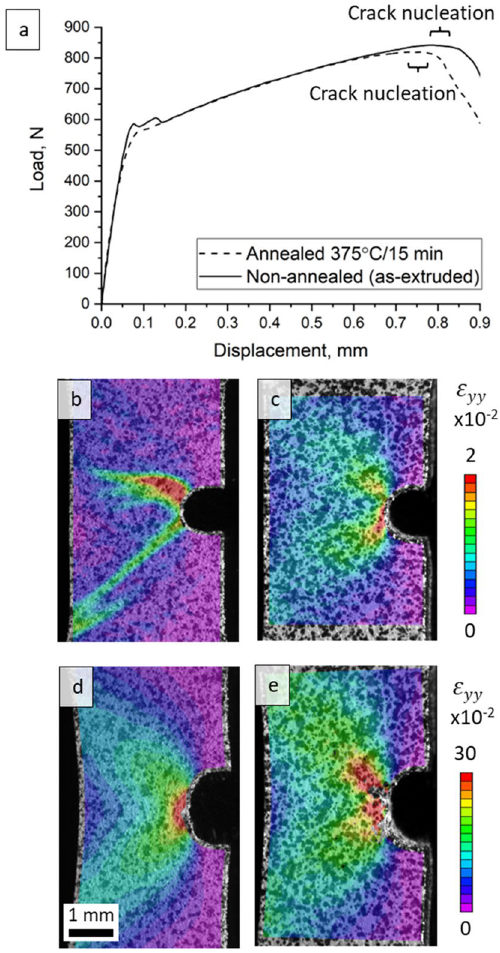
Figure 6. ( a ) Comparison of load–displacement (P-δ) curves recorded during tension of notched as-extruded and annealed specimens of the Mg–1.5Nd alloy. ( b – e ) DIC strain fields ε yy illustrating the fields at the beginning of deformation ( b , c ) and at the beginning of crack nucleation ( d , e ). These are indicated by brackets in ( a ): as extruded specimens (left) and annealed specimens (right). Note the similarity of the strain fields in (d and e) with a slightly higher strain localization in the annealed specimen.